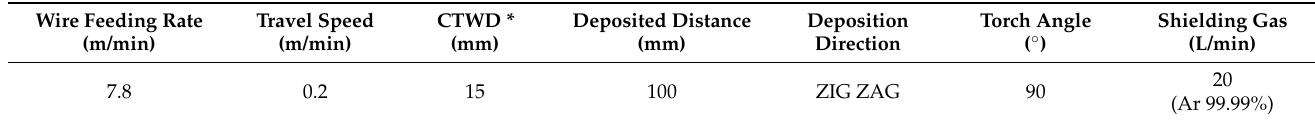
Table 2. Deposition parameter of the experiment.